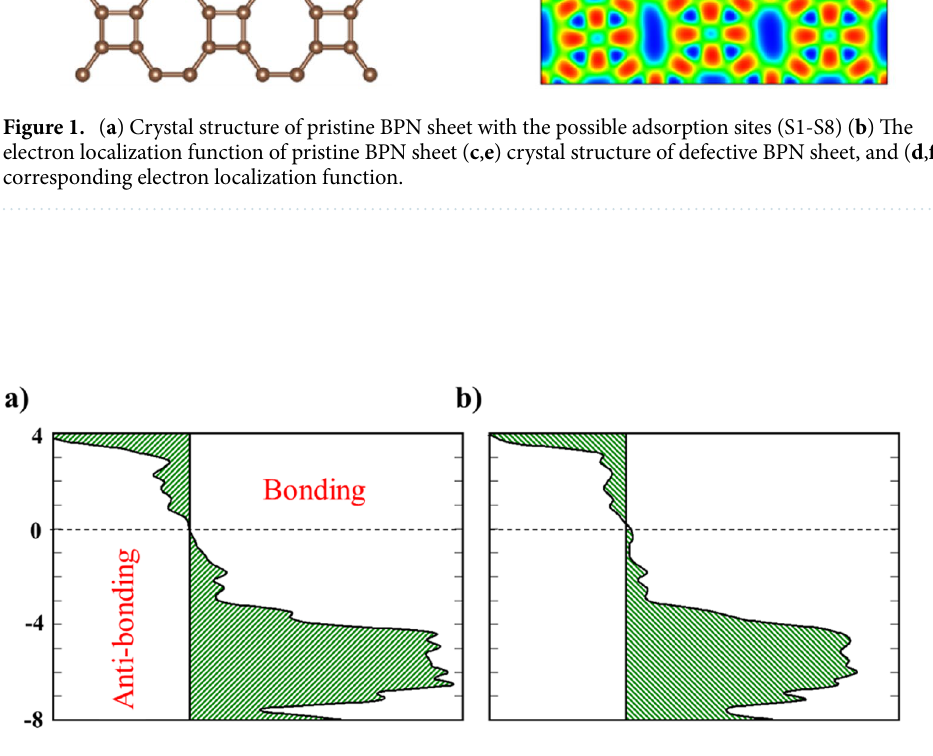
Figure 2. COHP for defected BPN sheet ( a ) corresponds to D1 defected sheet ( b ) corresponds to D2 defected sheet. The Fermi level is at